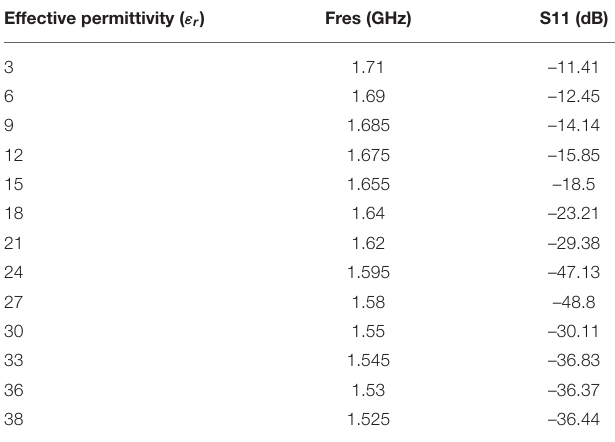
TABLE 1 | Effective permittivity ( ε r ) and resonance frequency